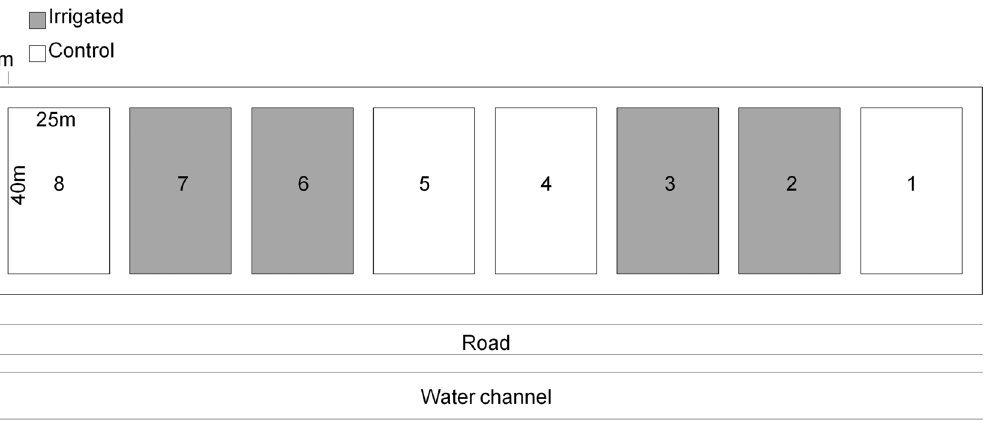
Figure 1. Experimental setup of the irrigation experiment in Pfynwald (VS). Irrigated plots (grey) and control plots (white) with the nearby water channel which was used for irrigation.